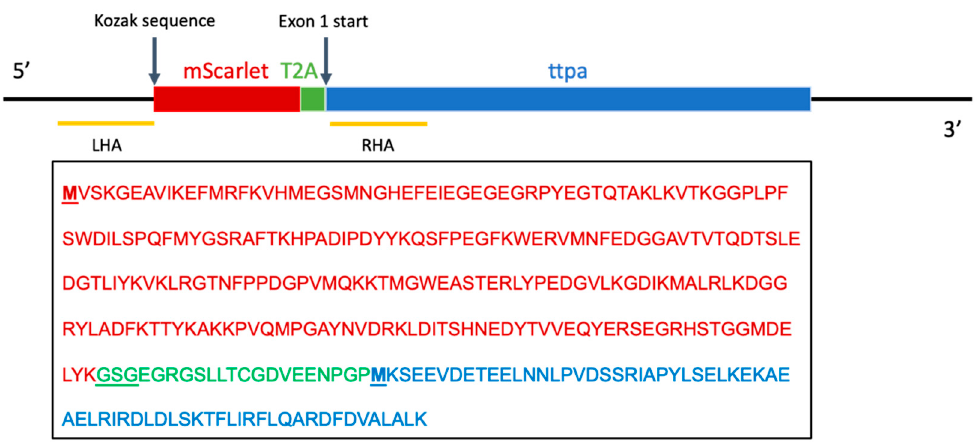
Figure 1. Knock-in strategy and designed protein sequence. LHA refers to the left homology arm and RHA refers to the right homology arm of the donor plasmid containing the mScarlet coding sequence. Amino acid sequences are denoted by color to indicate protein: mScarlet (red), GSG-T2A linker site (green) and exon 1 of ttpa (blue).